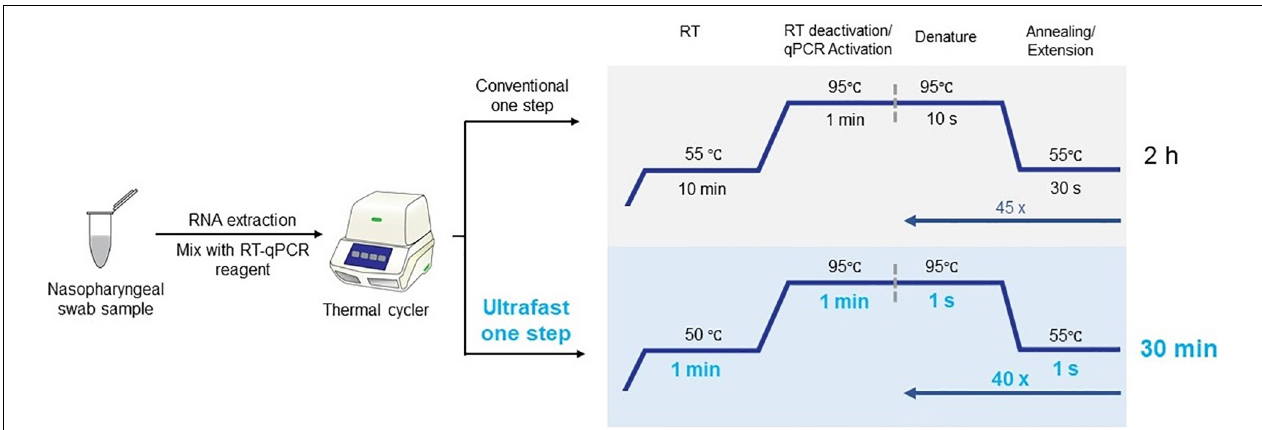
FIGURE 1 | Workflow of ultrafast one-step qRT-PCR with comparison with conventional qRT-PCR for SARS-CoV-2 detection.